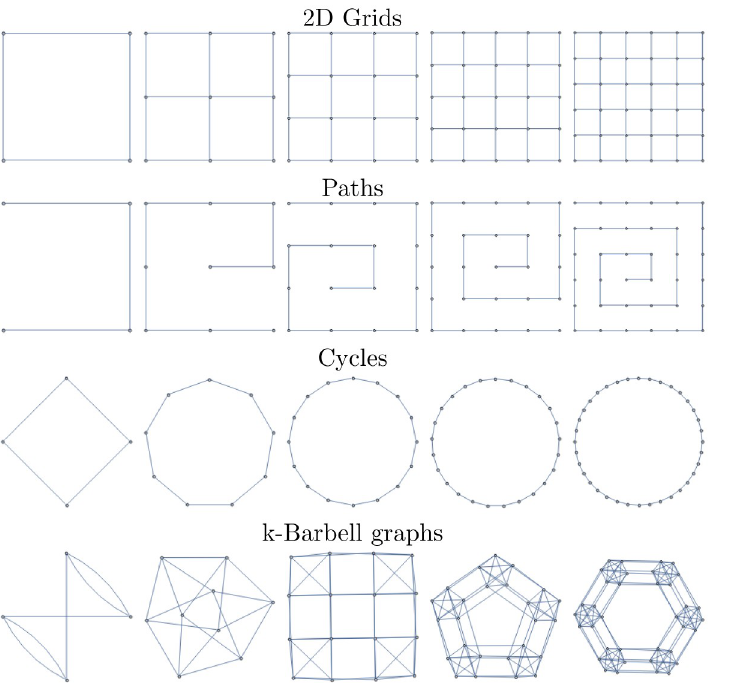
Fig 5. Graph lineages used in multiple numerical experiments in the main